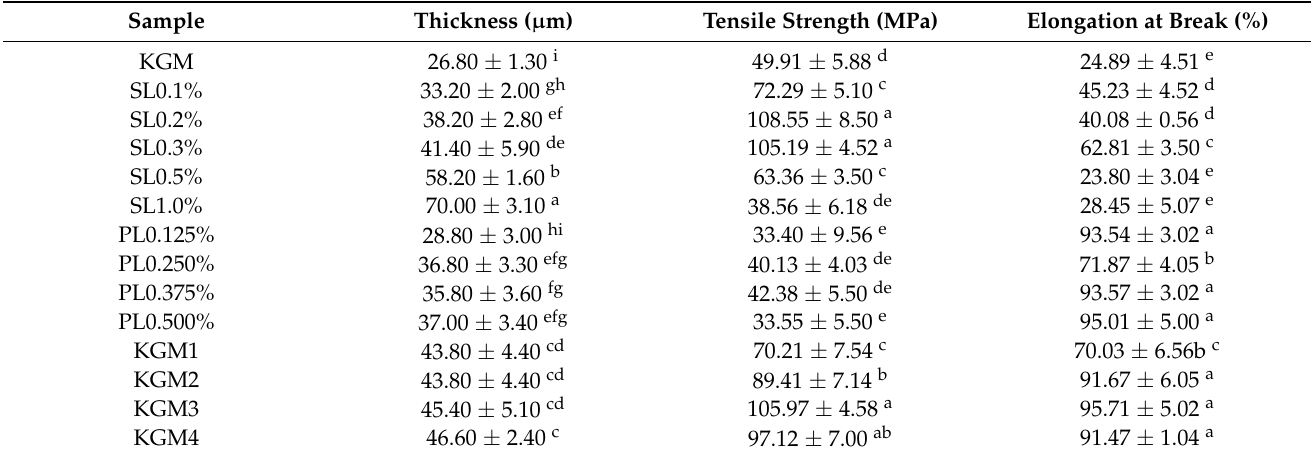
Table 1. Thickness and mechanical performance of films with different